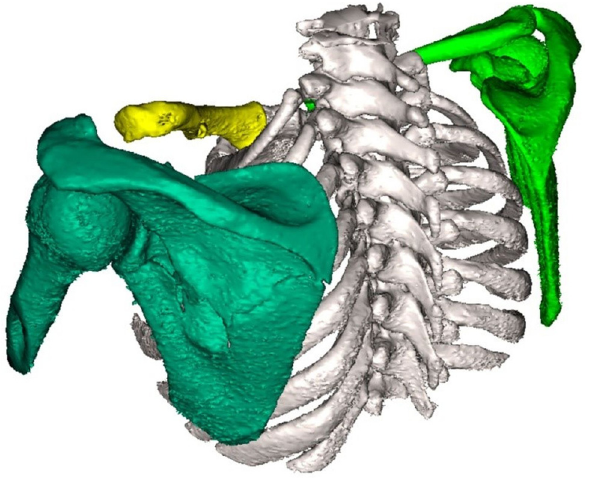
Figure 4: Mirroring the image.